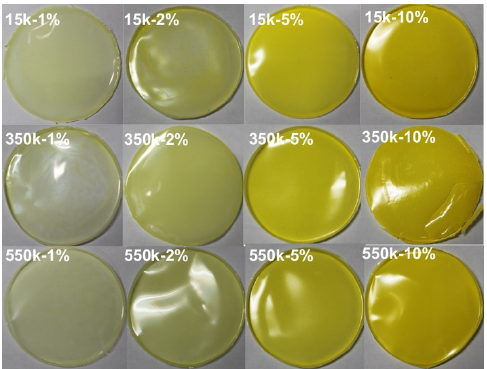
Figure 2. Green emissive CuInS 2 NCs/PMMA composite films with different mass concentration and PMMA molecular weight. From left to right, the mass concentrations are 1 wt%, 2 wt%, 5 wt%, and 10 wt%, respectively.